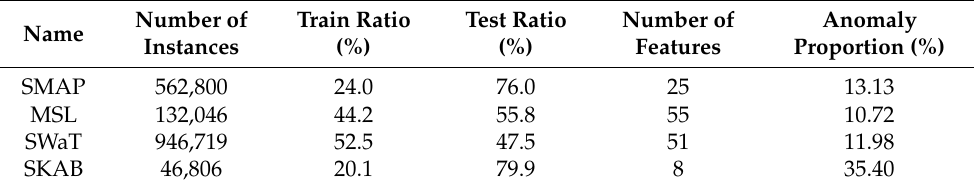
Table 1. Dataset data